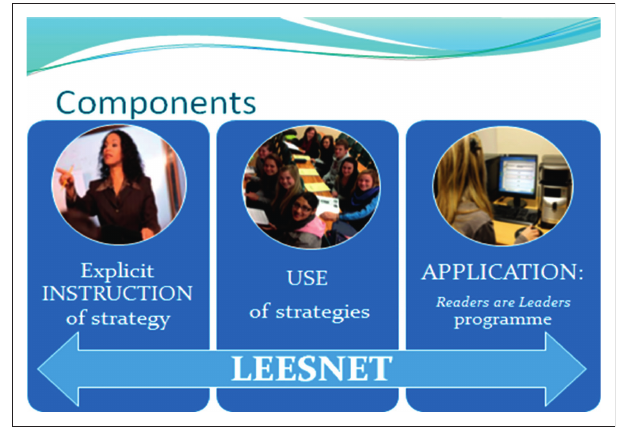
FIGURE 2: Academic reading